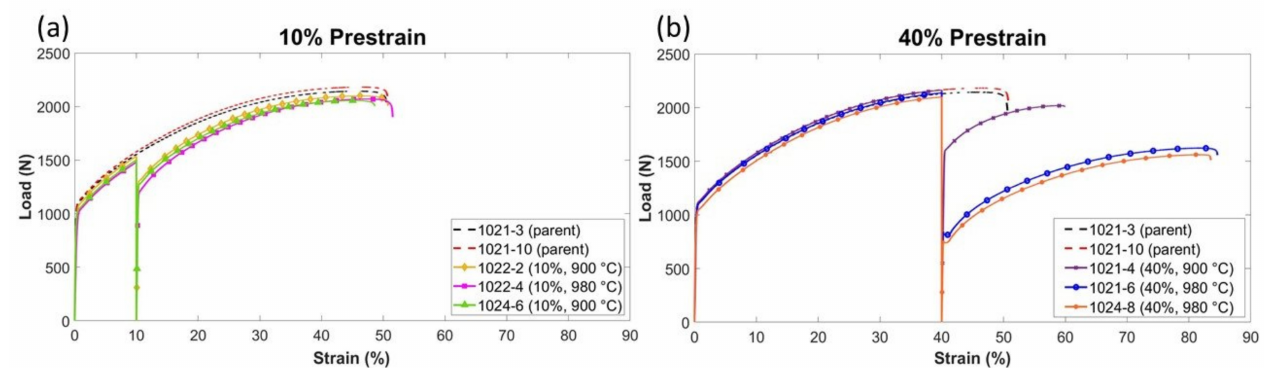
Figure 4. Total strain observed for post-heat-treatment specimens that underwent ( a ) 10% prestrain and ( b ) 40%